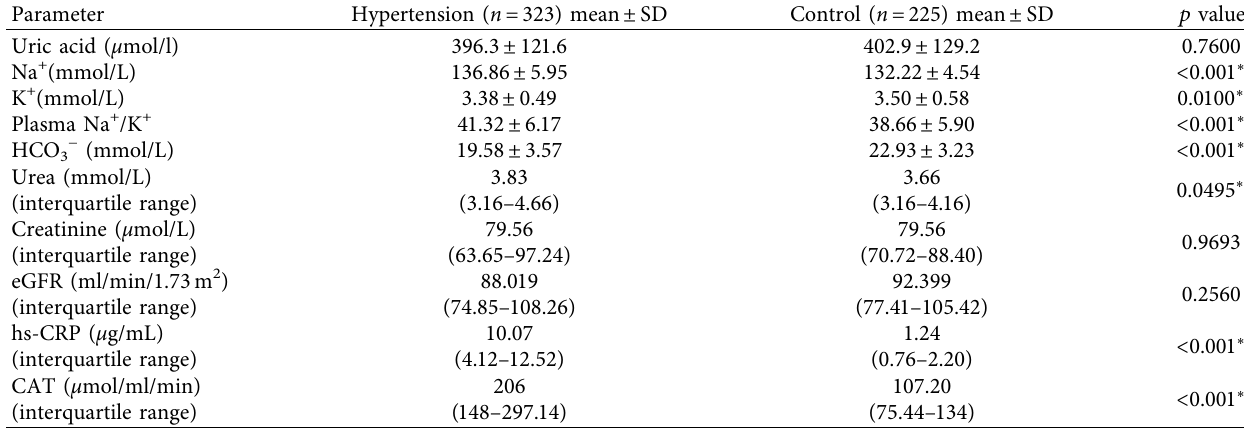
Table 2: Biomarkers of renal function, plasma sodium-potassium ratio, and inflammatory biomarkers between hypertensive and control volunteers.